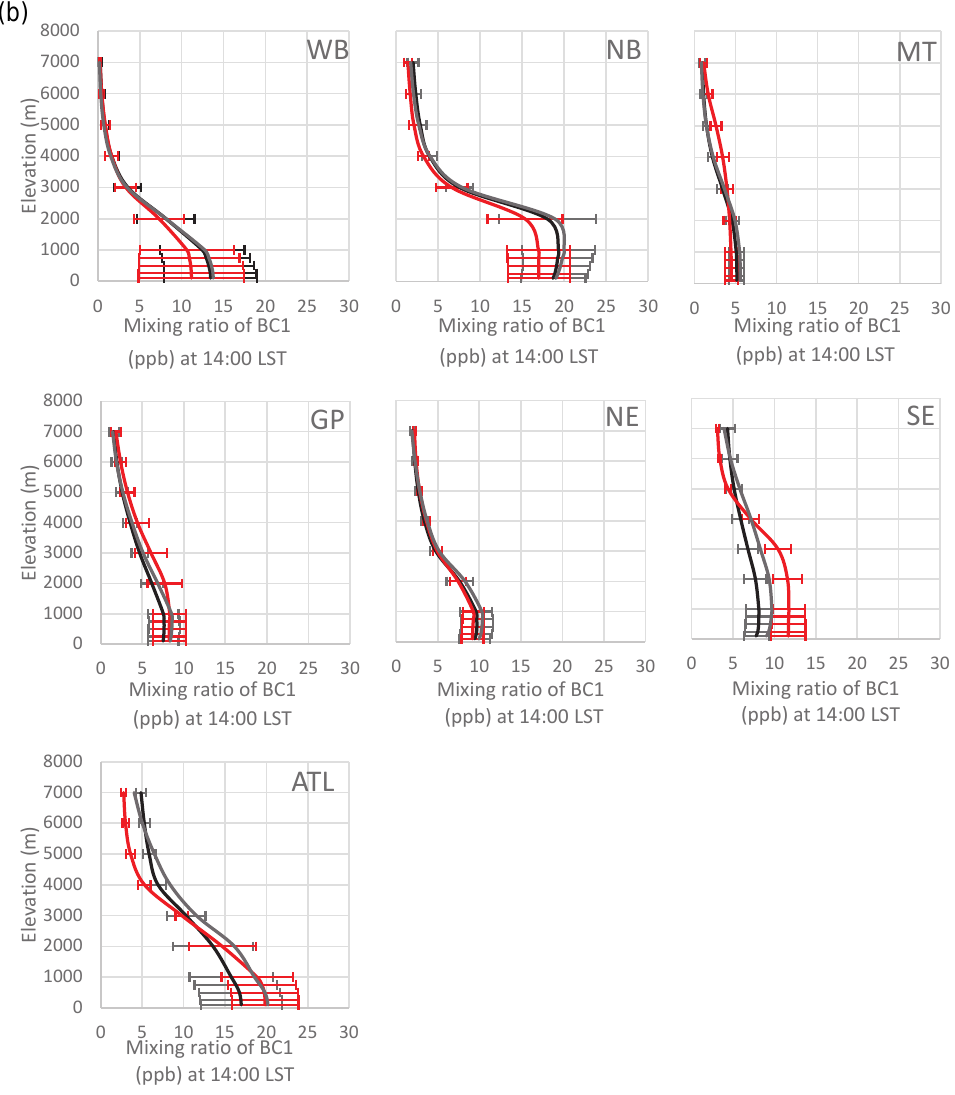
Figure 6. (a) Seasonal averaged vertical profiles of ( BC2 + BC3 ) (in ppb) for WRF / CMAQ (black), WRF / CMAQ_nocldmix (grey), and COSMO-CLM / CMAQ (red) in summer over the subregions at their local standard time of 14:00. The bars represent the standard devia- tions over the subregion (the standard deviations of WRF / CMAQ_nocldmix are not shown, as the values are almost the same as those of WRF / CMAQ). The numbers in the legend are the seasonal averaged maximum PBL height during the daytime over each subregion for WRF / CMAQ (in black) and for COSMO-CLM / CMAQ (in red). (b) Same as (a) , but for BC1 (in ppb).